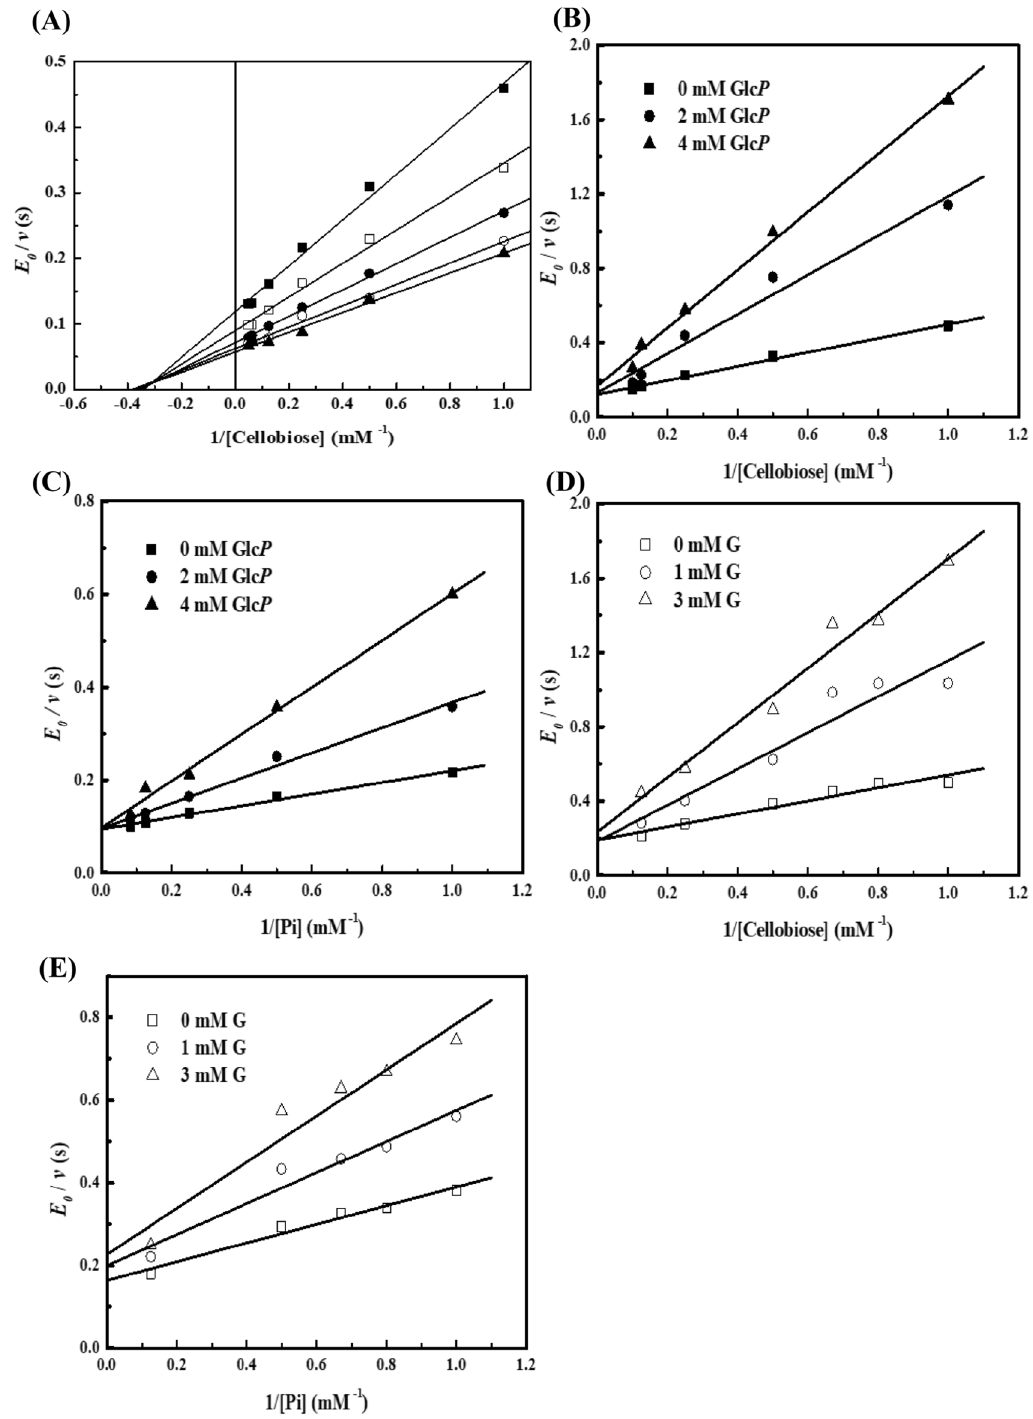
Figure 4. Kinetic mechanisms of the phosphorolytic reaction. ( A ) Double reciprocal plots of cellobiose phosphorolysis catalyzed by Cb CBP. The concentration of Pi was as follows: 1 mM (filled square), 2 mM (open square), 4 mM (filled Circle), 8 mM (open circle), and 12 mM (Filled triangle). R 2 > 0.99. ( B – E ) Inhibition patterns of the products against the substrates. The other substrates were 1 mM Pi (B, D) and 2 mM cellobiose (C, E). B: Glu-1P against cellobiose, C: Glu-1P against Pi, D: glucose against cellobiose, E: glucose against Pi. filled square and open square: none of the initial product, filled Circle: 2 mM Glu-1P, fillied triangle: 4 mM Glu-1P, open circle: 1 mM glucose, open triangle: 3 mM